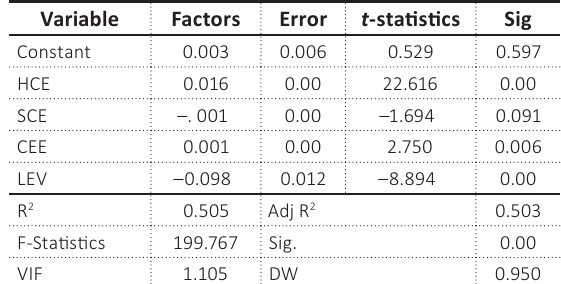
Table 4. Model 2